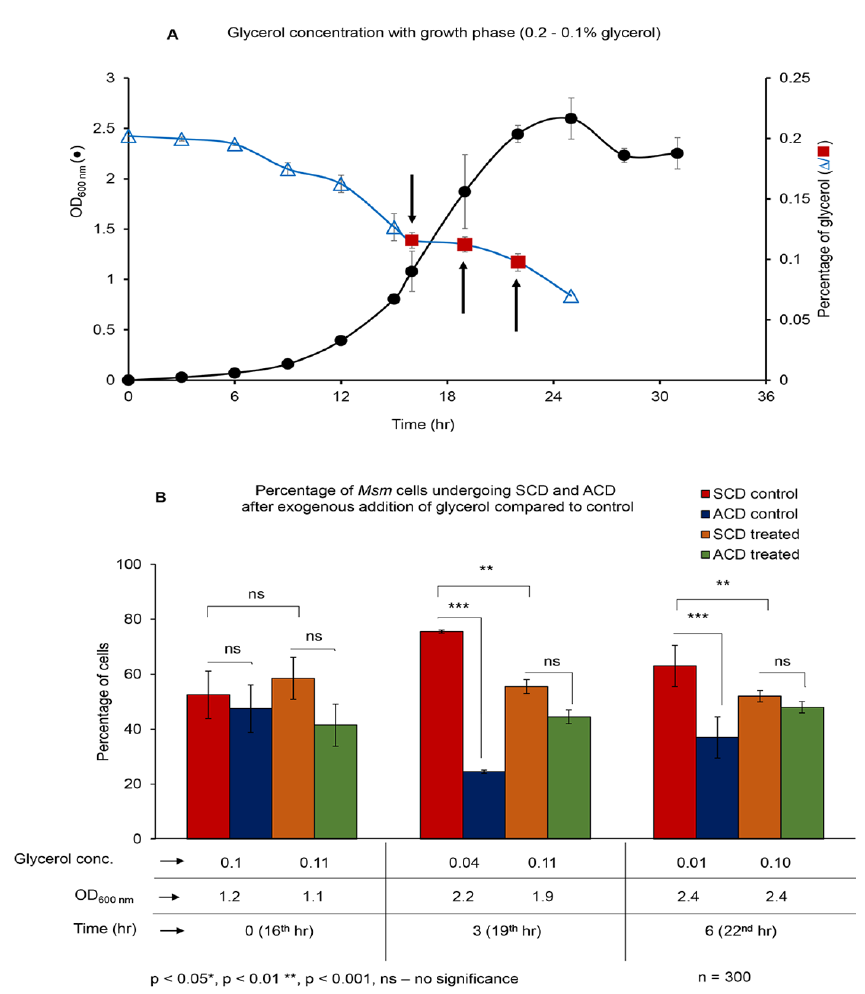
Figure 3. Proportion of the cells undergoing ACD/SCD after maintenance of glycerol at 0.1%, and growth curve with respect to OD. ( A ) ( ● ) Growth curve of Msm cells cultured in Middlebrook 7H9 liquid medium containing 0.2% glycerol and 0.05% Tween 80, with respect to ( ∆ ) glycerol concentration and ( (cid:4) ) after the exogenous addition of 0.05% glycerol at 16th, 19th, and 22nd h, as indicated by the arrows. ( B ) OD, glycerol concentration and proportion of SCD (red and orange bar) and ACD (blue and green bar) after the exogenous addition of glycerol at 0 h, 3rd h, and 6th h compared to the control culture without added glycerol at the same time point ( n = 300. The data shown are for biological triplicates and represented with mean values ± s.d. p < 0.01 **, p < 0.001 ***, ns—no significance via two-tailed t